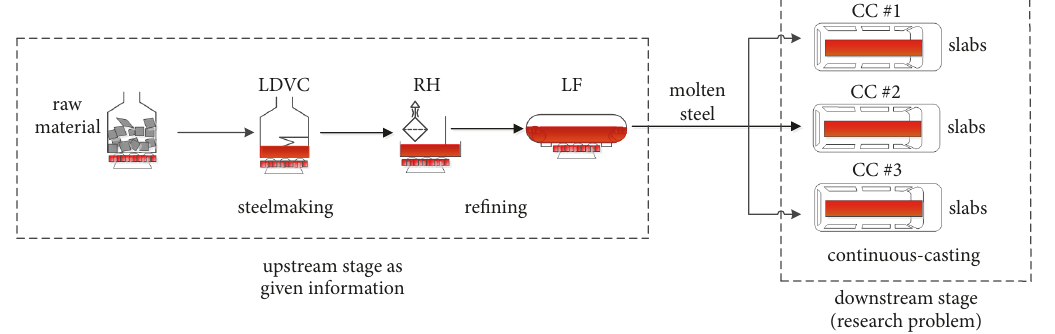
Figure 1: Steelmaking and continuous-casting